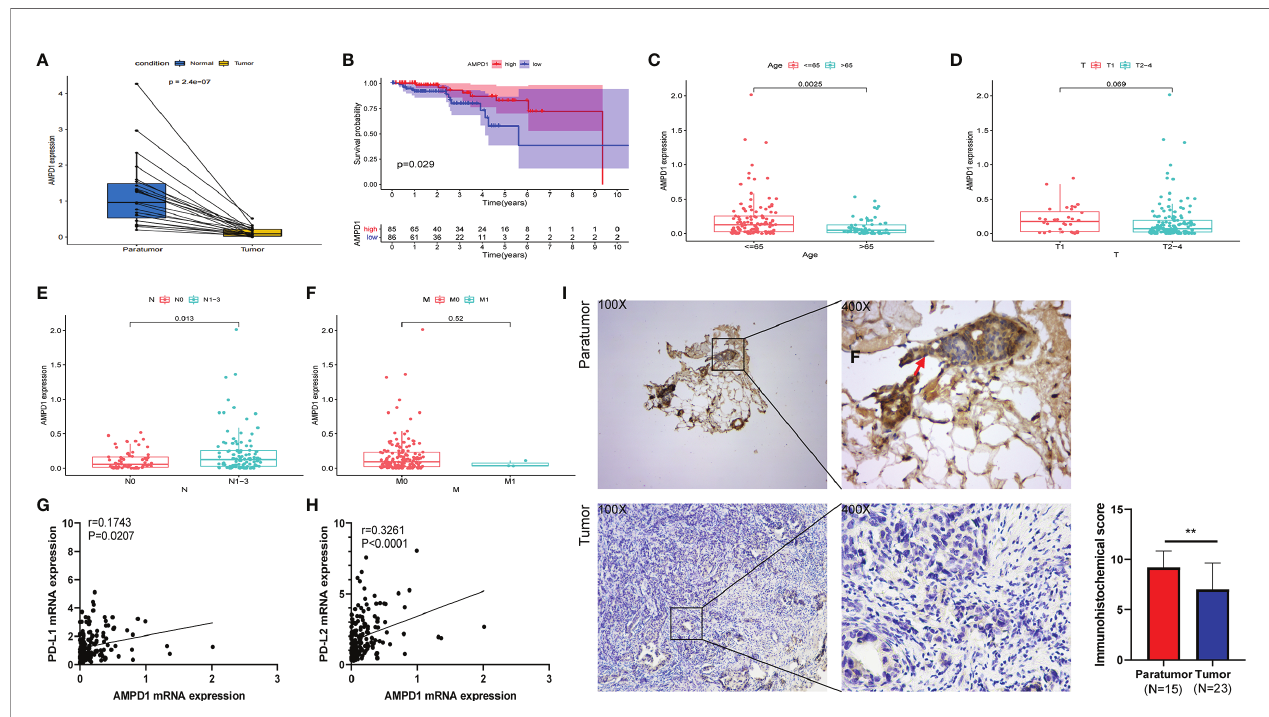
FIGURE 4 | AMPD1 expression, survival, and clinicopathological characteristic analyses. (A) AMPD1 was differentially expressed between HER2+ BC tumor tissues and paratumor tissues (Wilcoxon rank sum test p < 0.001). (B) Survival analysis of HER2+ BC patients with low and high AMPD1 expression (based on median expression) in the TCGA database (log-rank test p = 0.029). (C – F) Kruskal-Wallis rank sum tests of the associations between AMPD1 expression and clinicopathological features. (G, H) Correlation analysis of AMPD1 expression and the mRNA levels of PD-L1 (p = 0.0207, rPearson = 0.1743) or PD-L2 (p < 0.0001, rPearson = 0.3261) in